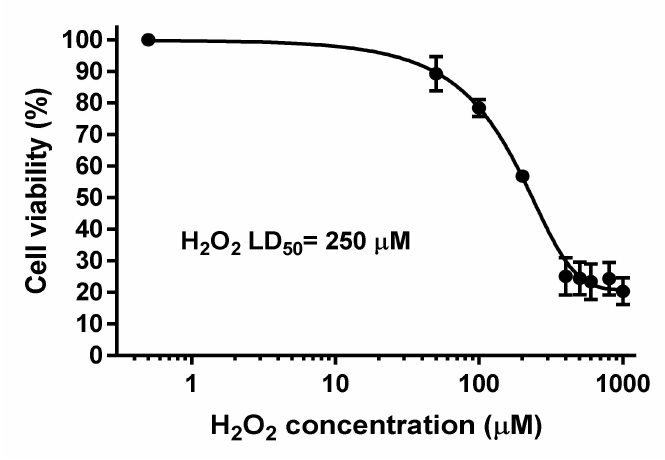
Figure 7. Determination of the H 2 O 2 lethal dose (LD50, µ M) after 24-h incubation for SH-SY5Y cells. Values are the Mean ± SD of six different experiments carried out in quadruplicate (r2: